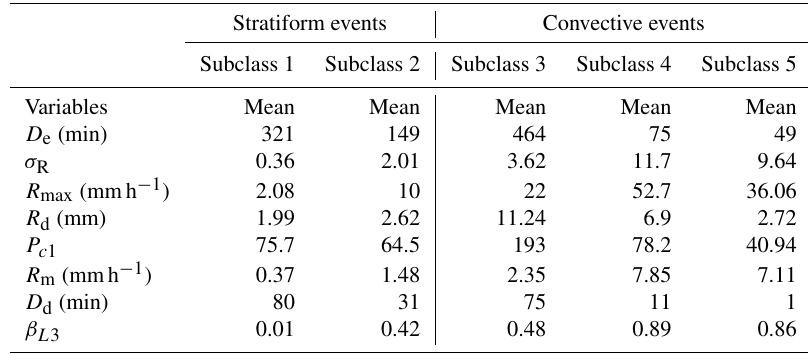
Table 5. Summary of the rain event subclasses computed with the learning data set. Stratiform